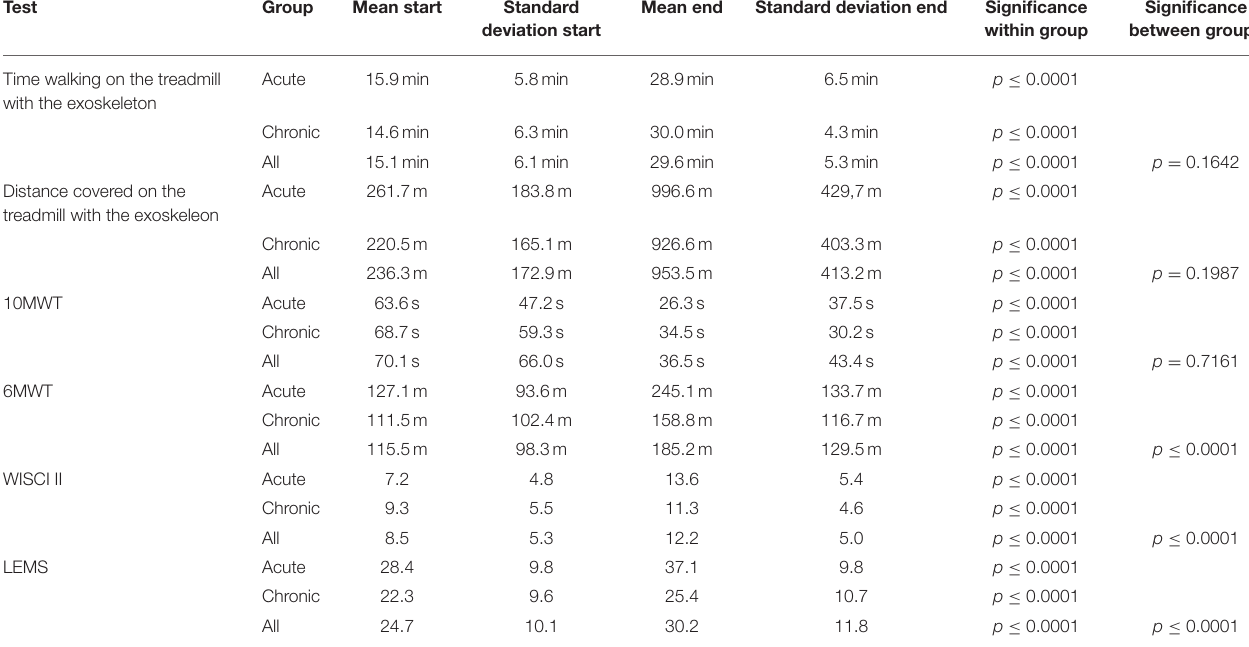
TABLE 2 | Means, standard deviations, and significance.